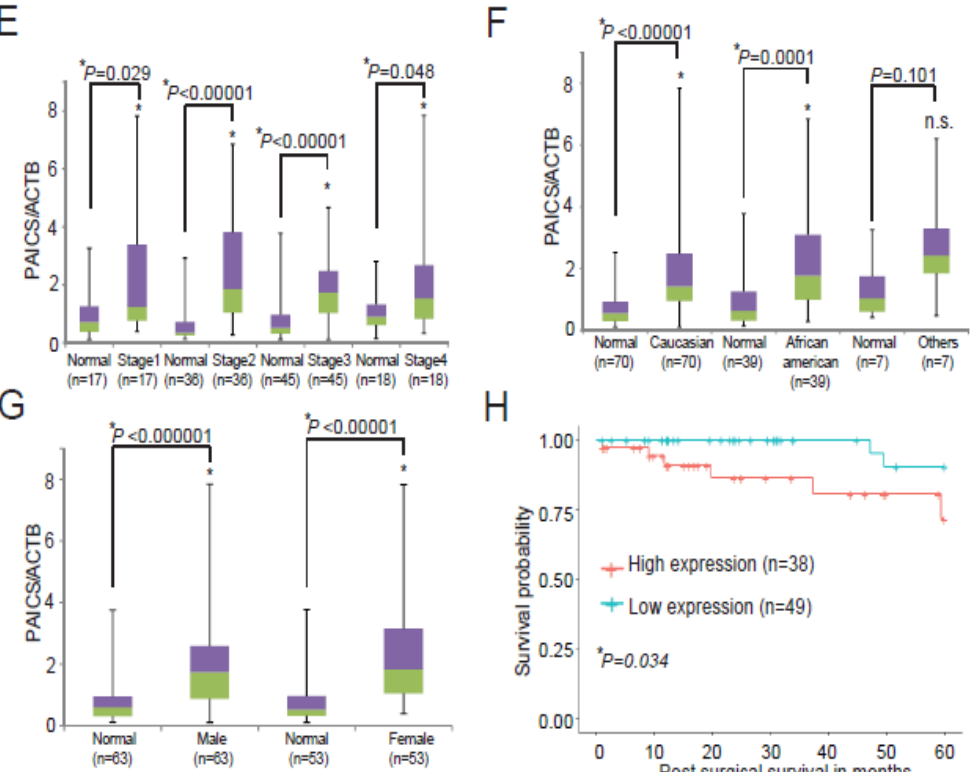
Figure 1. PAICS mRNA overexpression in colorectal cancers (CRCs). ( A ) Information on gene expression profiling obtained from the Oncomine database [20] showing the expression of phosphoribosylaminoimidazole carboxylase, phosphoribosylaminoimidazole succinocarboxamide synthetase PAICS in CRC tissues. ( B ) UALCAN data [22] showing greater PAICS expression in colon adenocarcinomas ( n = 286) compared to normal colon tissues ( n = 41). ( C ) UALCAN data showing stage-wise PAICS expression. ( D ) In-house validation by quantitative polymerase chain reaction (qPCR) showing PAICS expression using RNA from paired CRC ( n = 116) and normal colon tissues ( n = 116). qPCR analysis showing PAICS expression in various pathologic stages ( E ). Race ( F ), and gender ( G ). For qPCR normalization, β -actin (ACTB) was used as a reference gene. ( H ) Kaplan-Meier survival curves based on the PAICS mRNA expression status of CRC patients (blue lines indicate patients with low PAICS expression ( n = 49); red lines indicate patients with high ( n = 38) PAICS expression).